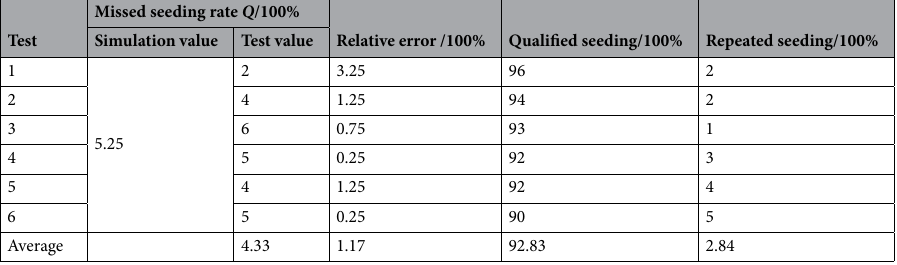
Table 5. Results and comparison of field validation